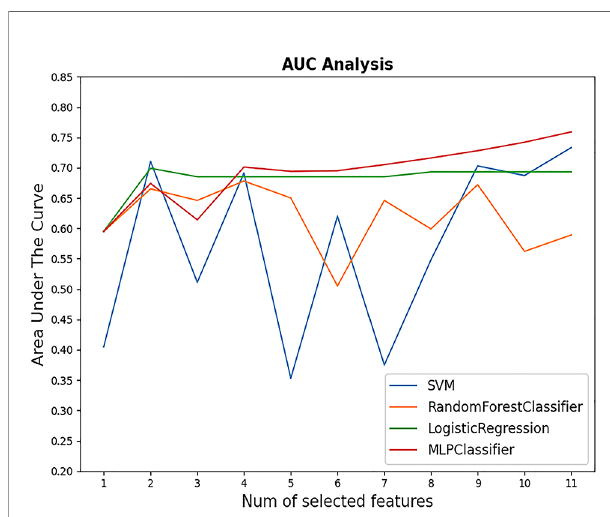
FIGURE 1 | AUC values of four models with different numbers of structured features selected. The highest AUC value appeared when MLP with 11 variables came into use (AUC = 0.759).